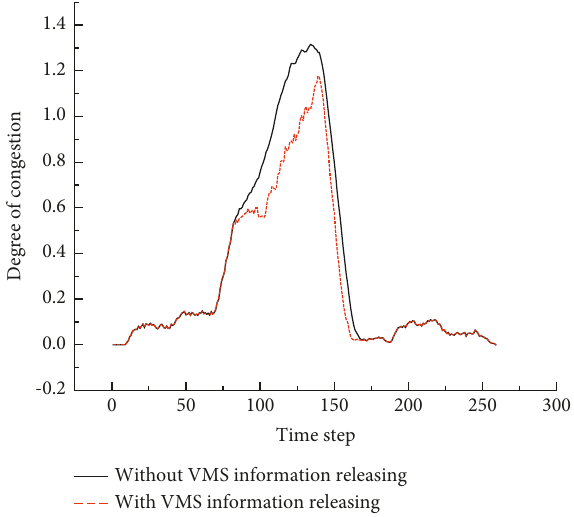
Figure 24: The change of congestion degree of the road section (20, 19) during traveling for the scenario of